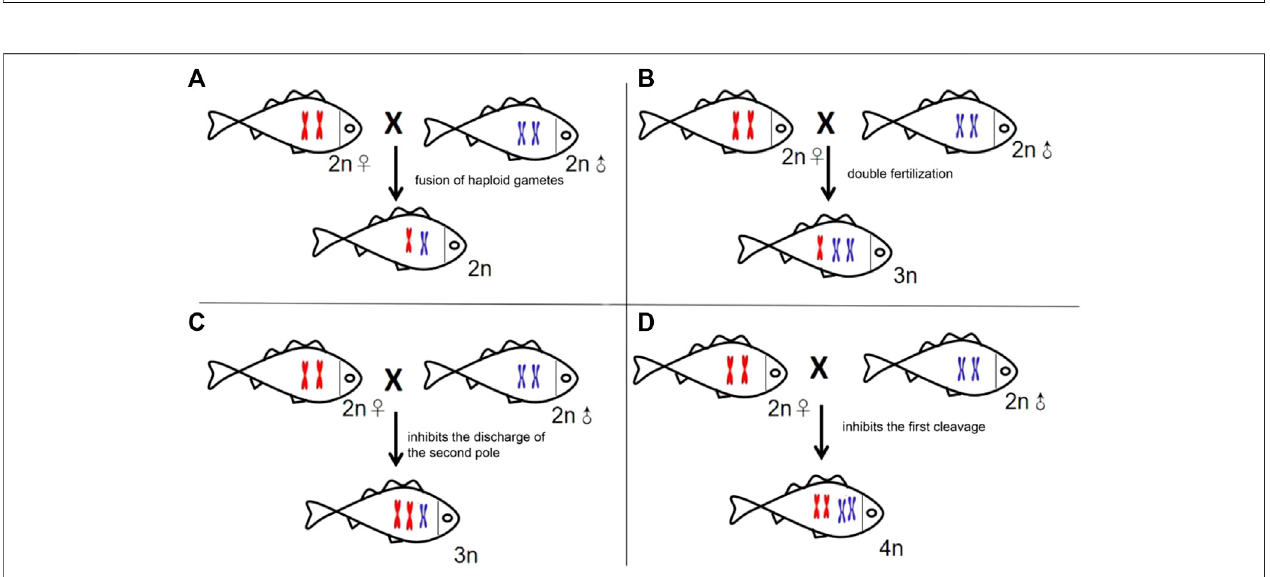
FIGURE 6 | Schematic presenting the four types of formation mechanisms of the heterogeneous hybridization offspring. (A) Allodiploid resulting from the fusion of haploid gametes. (B) Allotriploid derivingfromdoublefertilization. (C) Allotriploidresultingfromtheexpulsioninhibitionofthesecondpole. (D) Allotetraploidderivingfrom the impeding of the fi rst